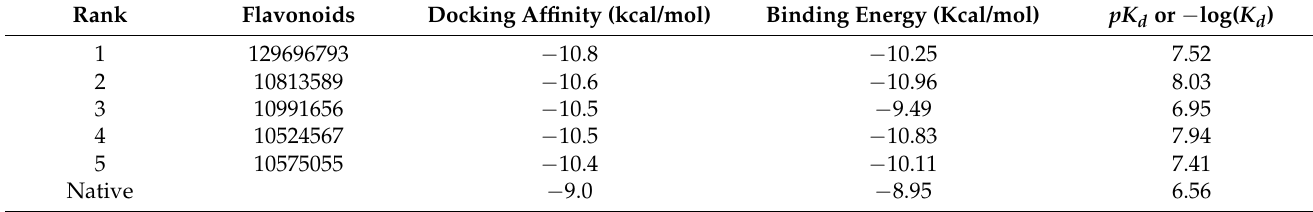
Table 1. The selected flavonoids and the binding strength score against MEK1 (Autodock Vina docking energy, X-Score binding energy and pK d ). The higher the absolute values of the scores, the better the